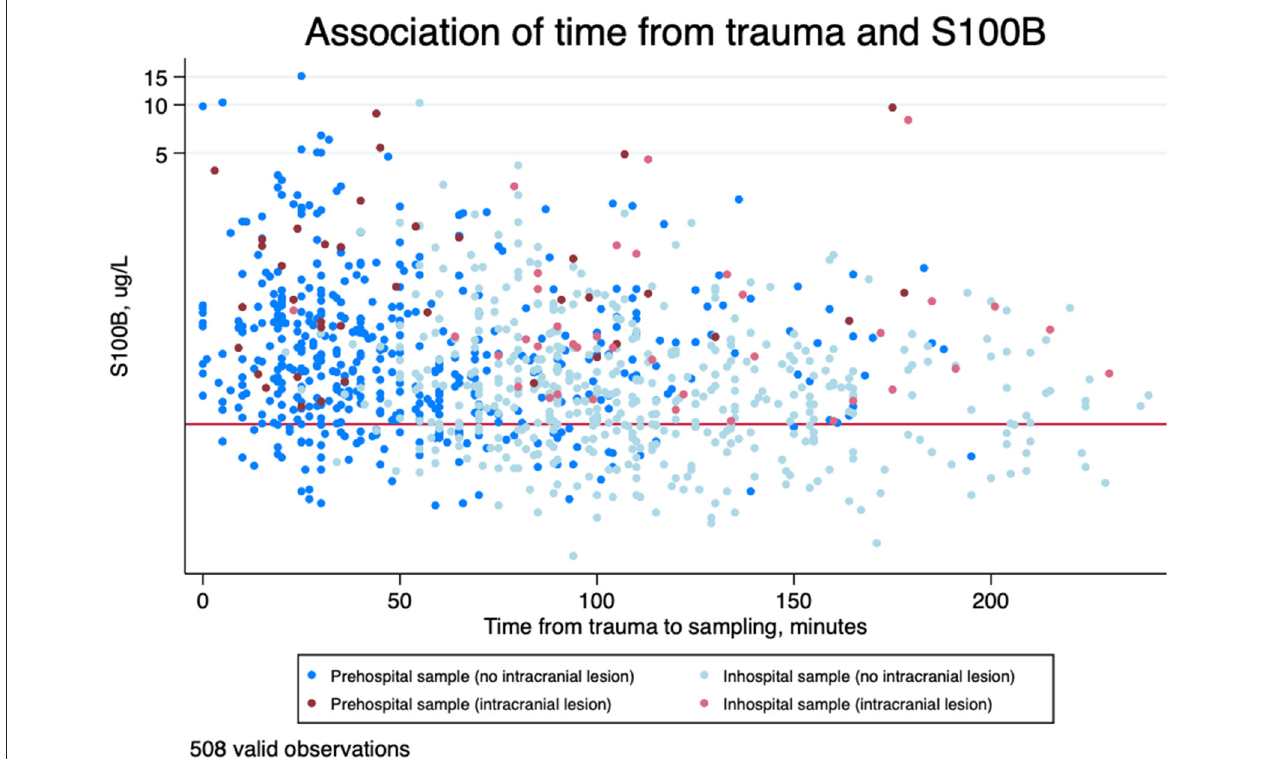
FIGURE 2 | Scatterplot of time from trauma to blood sampling in minutes on an ordinary scale (the first 4h) and serum S100B concentrations in µ g/L on a logarithmic scale in patients with and without intracranial lesion. The red line is indicating guideline cut-off at 0.10 µ g/l. N = 508 (valid timestamps within the first 4h).